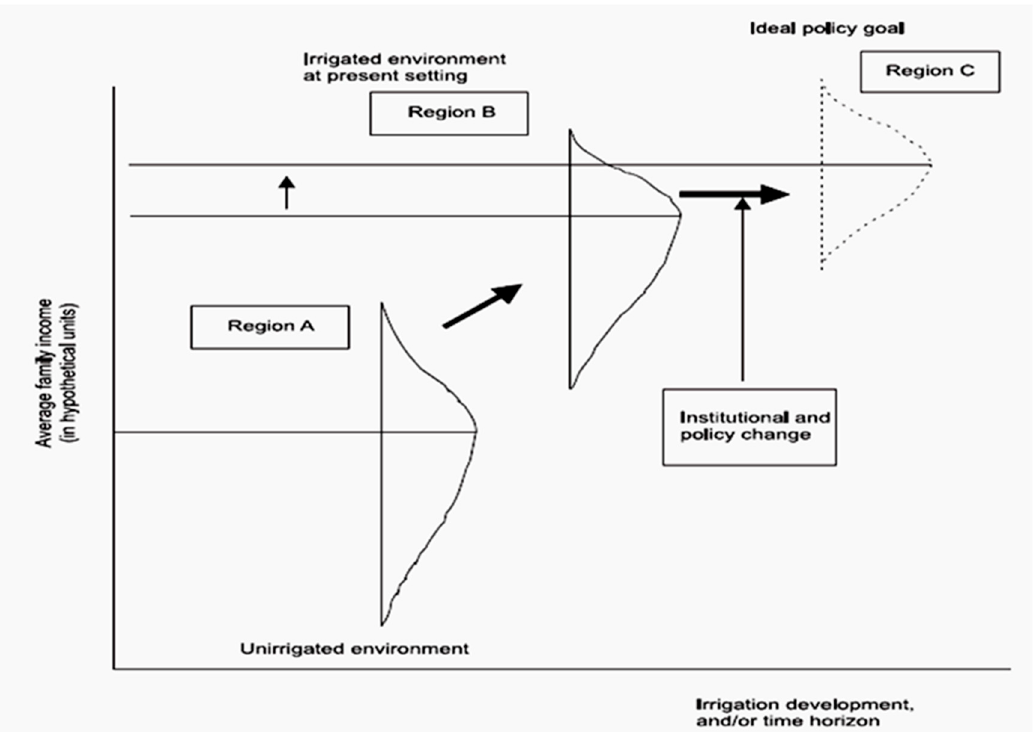
Figure 1. Conceptual framework for considering irrigation development ([20], p. 14).